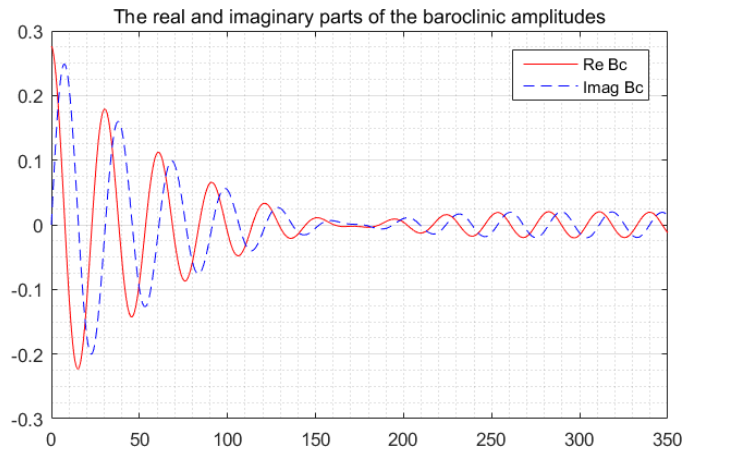
Figure 2. Asymptotically small H solutions developed on long time scales: T = Ht . Real and imaginary parts of baroclinic Rossby wave amplitude. The results in each case match the analytical solutions of (36)–(38). The calculations are performed for µ = 0.015, F = β = 20, H = 0.05, and k = l = π